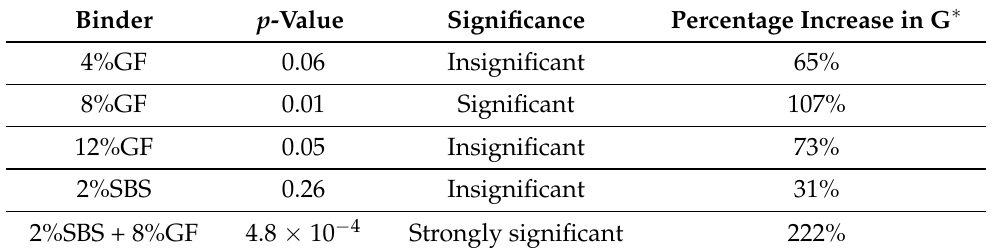
Table 5. F-test comparing shear modulus of modified binders to the neat binder.